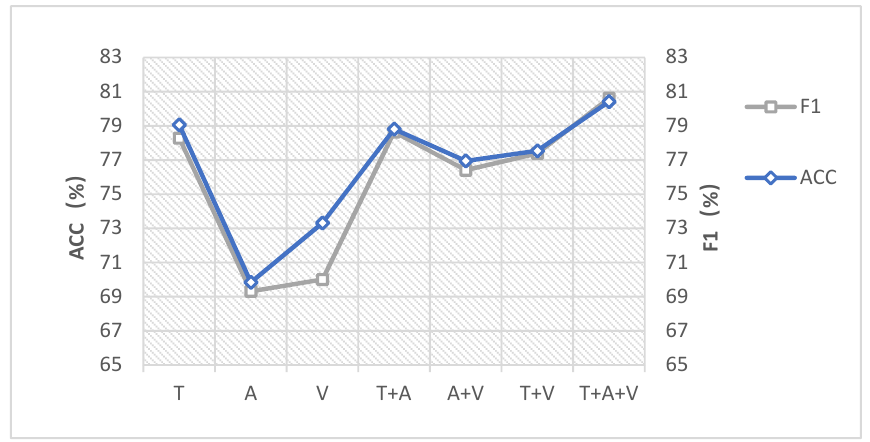
Figure 4. Ablation experiment results.